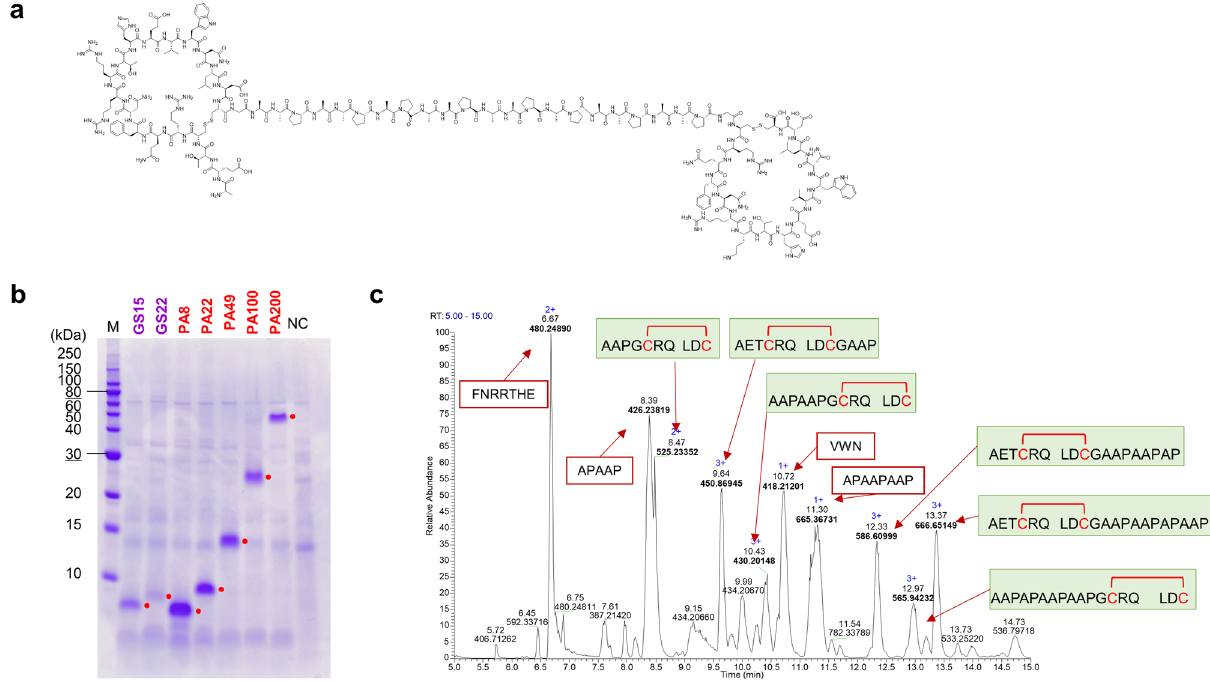
Fig. 2 Production of HGF mimetic STaMPtides. a Chemical structure of HGF mimetic aMD4dY-PA22. b SDS-PAGE analysis of secreted linker variants of HGF mimetic STaMPtides. Red dots indicate STaMPtide-derived bands. M: marker, NC: negative control supernatant (mock-vector-transfected). c Identi fi cation of disul fi de bonds of aMD4dY-PA22. aMD4dY-PA22 was submitted for thermolysin digestion without reductive alkylation, and peptide fragments were analyzed by LC – MS/MS. The base peak chromatogram of 5 – 15 min is shown, and peaks of disul fi de-containing fragments are highlighted in green